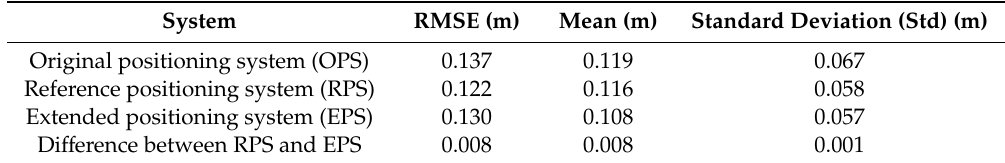
Table 4. Positioning error using the extended system.